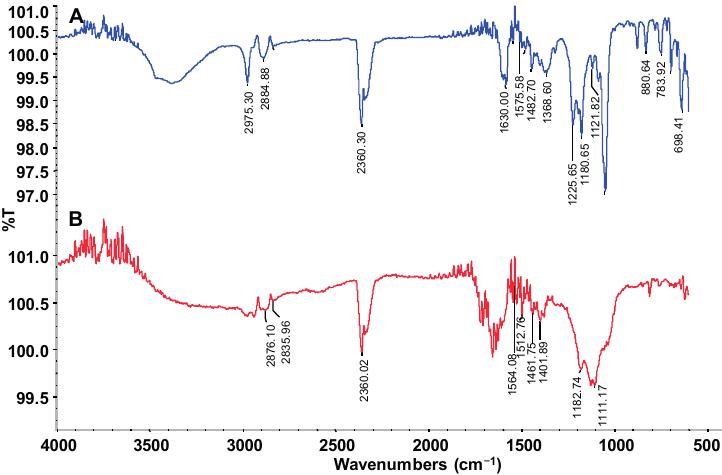
Figure 7. FTIR profile of ( A ) CR dye and ( B ) its decolorized products obtained after treatment with PUF-immobilized microbial consortium in an upflow column